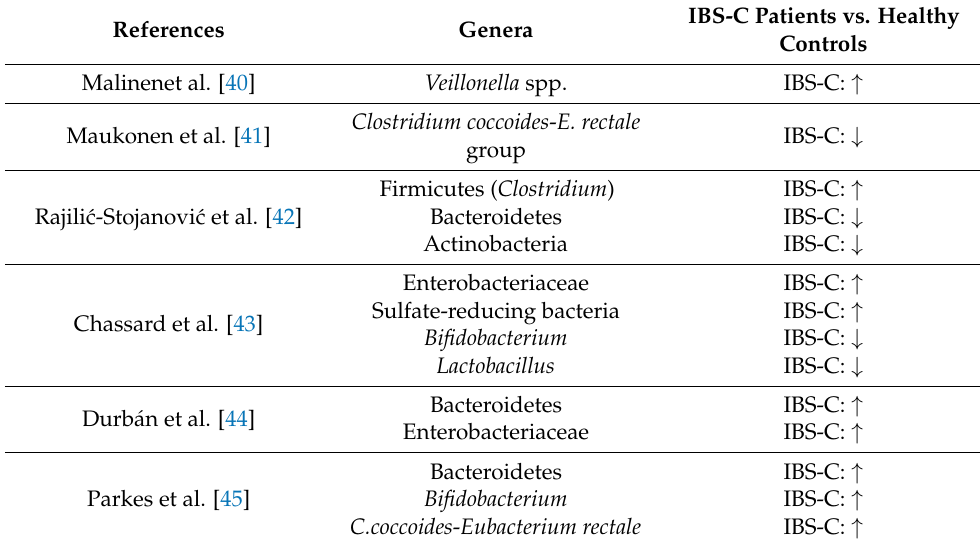
Table 1. Microbiota composition in IBS-C subjects versus healthy controls